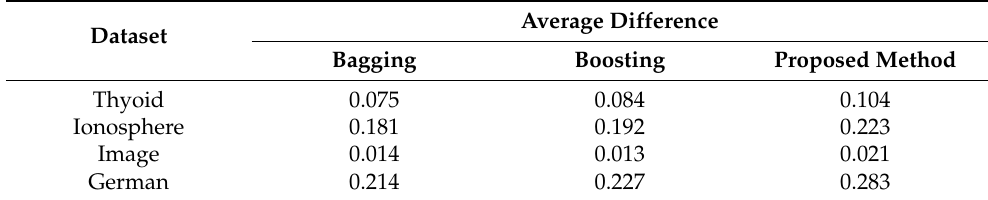
Table 2. Average difference degree between base